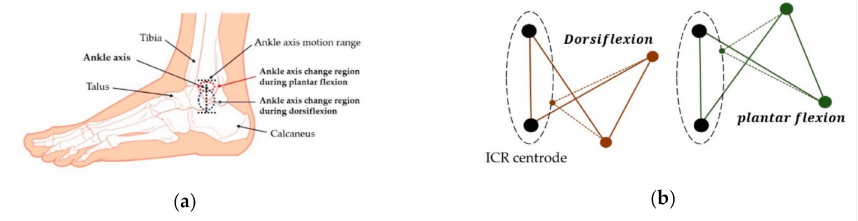
Figure 1. Overview of ankle anatomy and four-bar linkage: ( a ) anatomical structure of the human ankle, and talocrural joint position changes according to dorsiflexion (DF) and plantar flexion (PF); ( b ) Instantaneous center of rotation (ICR) position change according to the movement of the four- bar